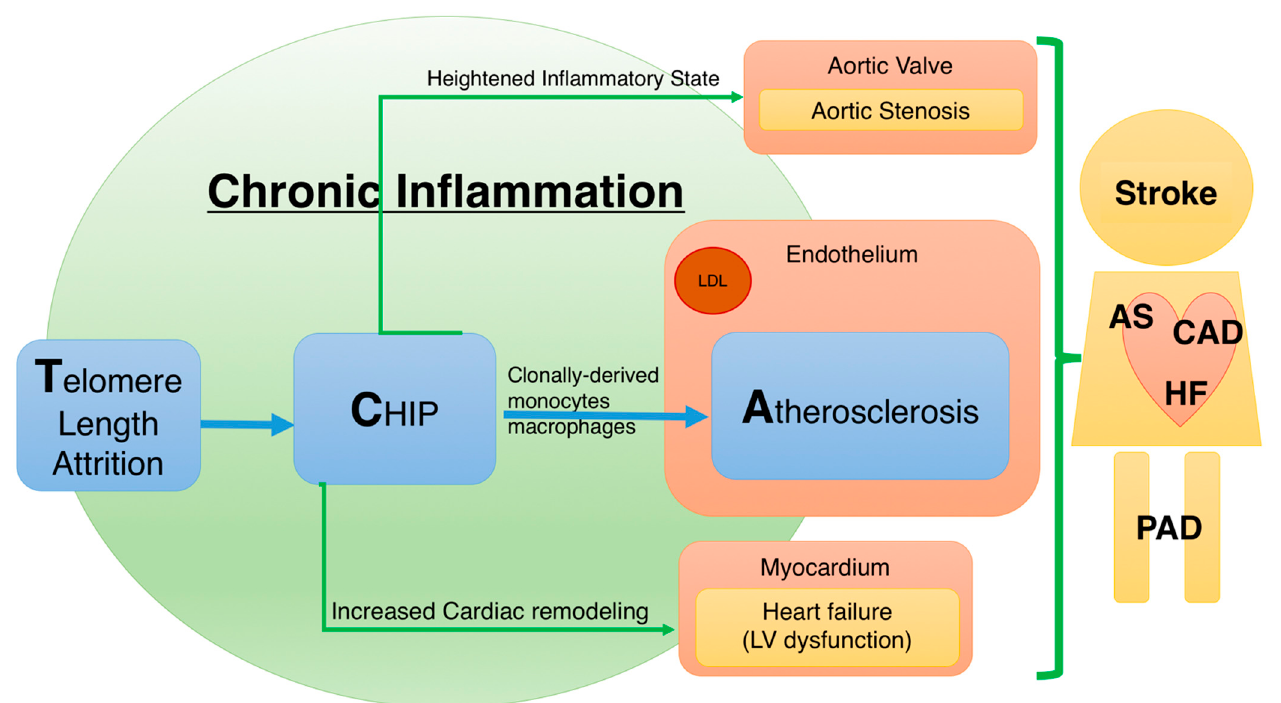
Figure 1. Telomere–CHIP–atherosclerosis (TCA) axis and cardiovascular disease. The TCA axis represents a novel cardiovascular treatment target in addition to traditional risk factors. With aging and telomere length attrition, hematopoietic stem cells develop clonal hematopoiesis of indeterminate potential (CHIP). CHIP then further aggravates chronic inflammation through multiple CHIP-related mutant gene signaling pathways, including Tet methylcytosine dioxygenase 2 ( TET2 ), additional sex combs-like 1 ( ASXL1 ), Janus kinase 2 ( JAK2 ), and DNA methyltransferase 3 alpha ( DNMT3A ). The affected cells, including macrophages, mast cells, and T cells, further increase the risk of atherosclerosis, coronary artery disease (CAD), aortic stenosis (AS), heart failure (HF), and possibly peripheral arterial occlusive diseases (PAD).